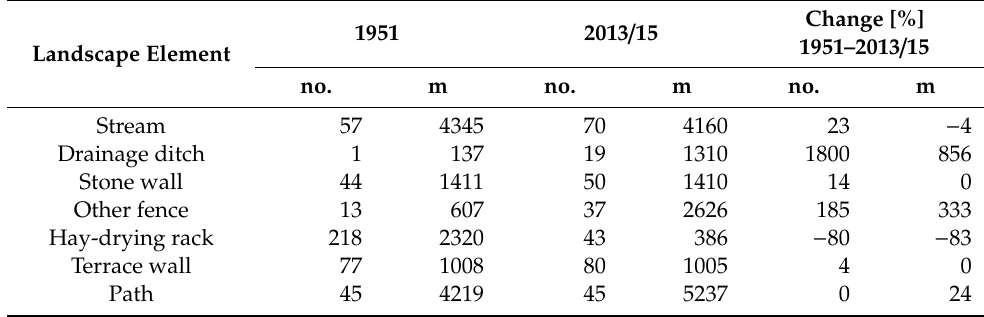
Table 4. Number and total length of selected linear landscape elements registered in Havrå Cultural Heritage Environment in 1951 and 2013 / 15, and change over